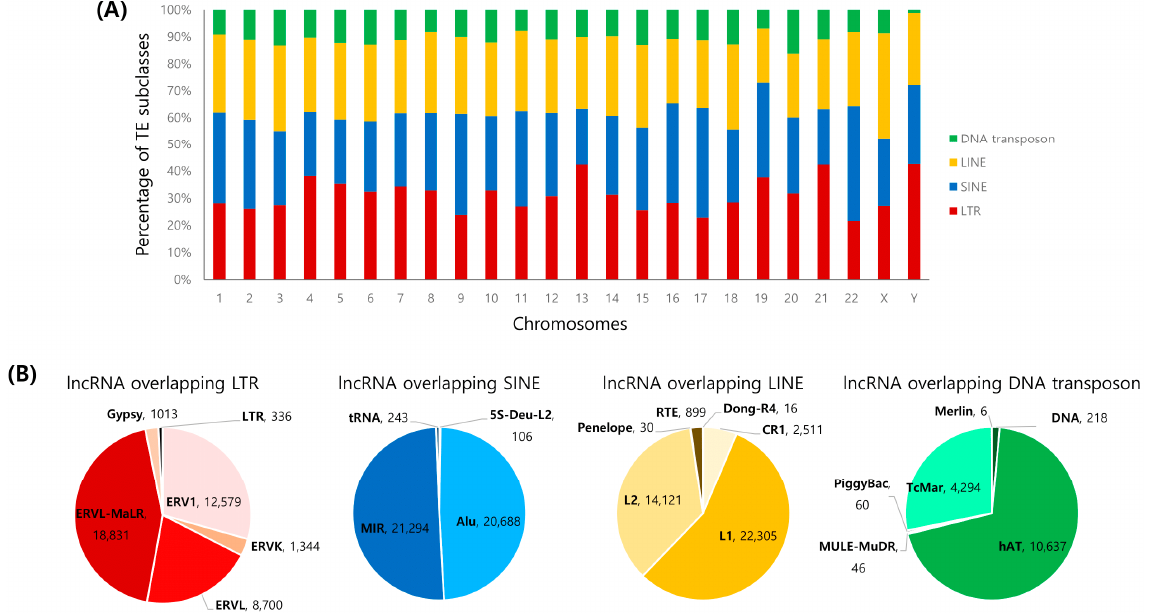
Figure 1. Percentage and composition of lncRNA transcripts overlapping TE sequences. ( A ) The percentage of TE subclasses produced by each chromosome; ( B ) The number of TE superfamilies overlapping with lncRNA transcripts from each TE subclasses: LTR, SINE, LINE, and DNA trans- poson.